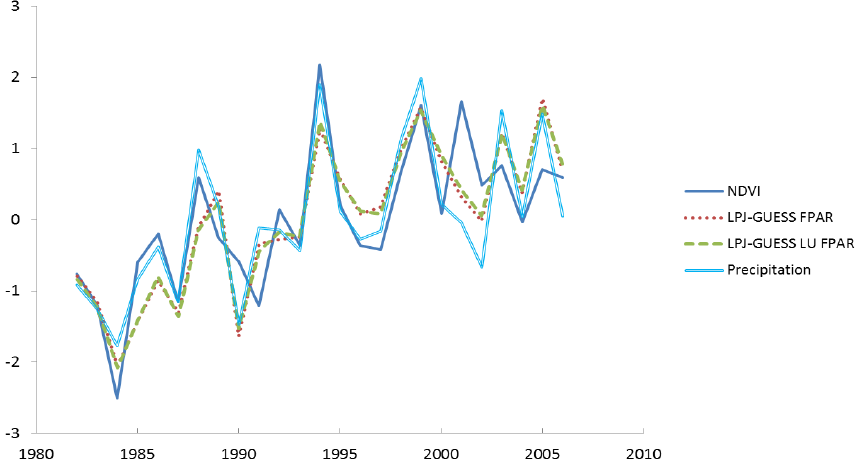
Fig. 7. Standardised mean anomalies for the Sahel region of yearly maximum observed NDVI and FPAR, modelled by LPJ-GUESS with and Figure 8 without land use functionality, and precipitation for the period 1982–2006.